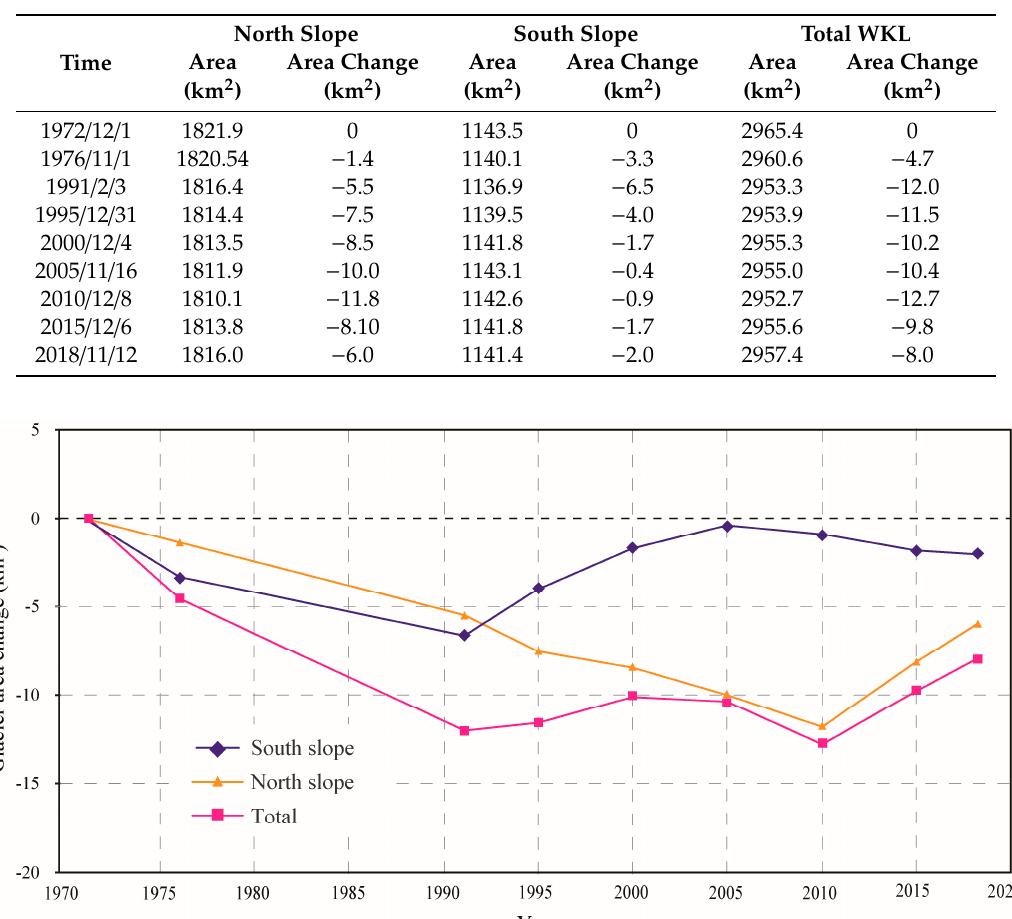
Table 2. Glacial area and changes from 1972 to 2018 in the WKL (the area change is based on the glacier area in 1972).